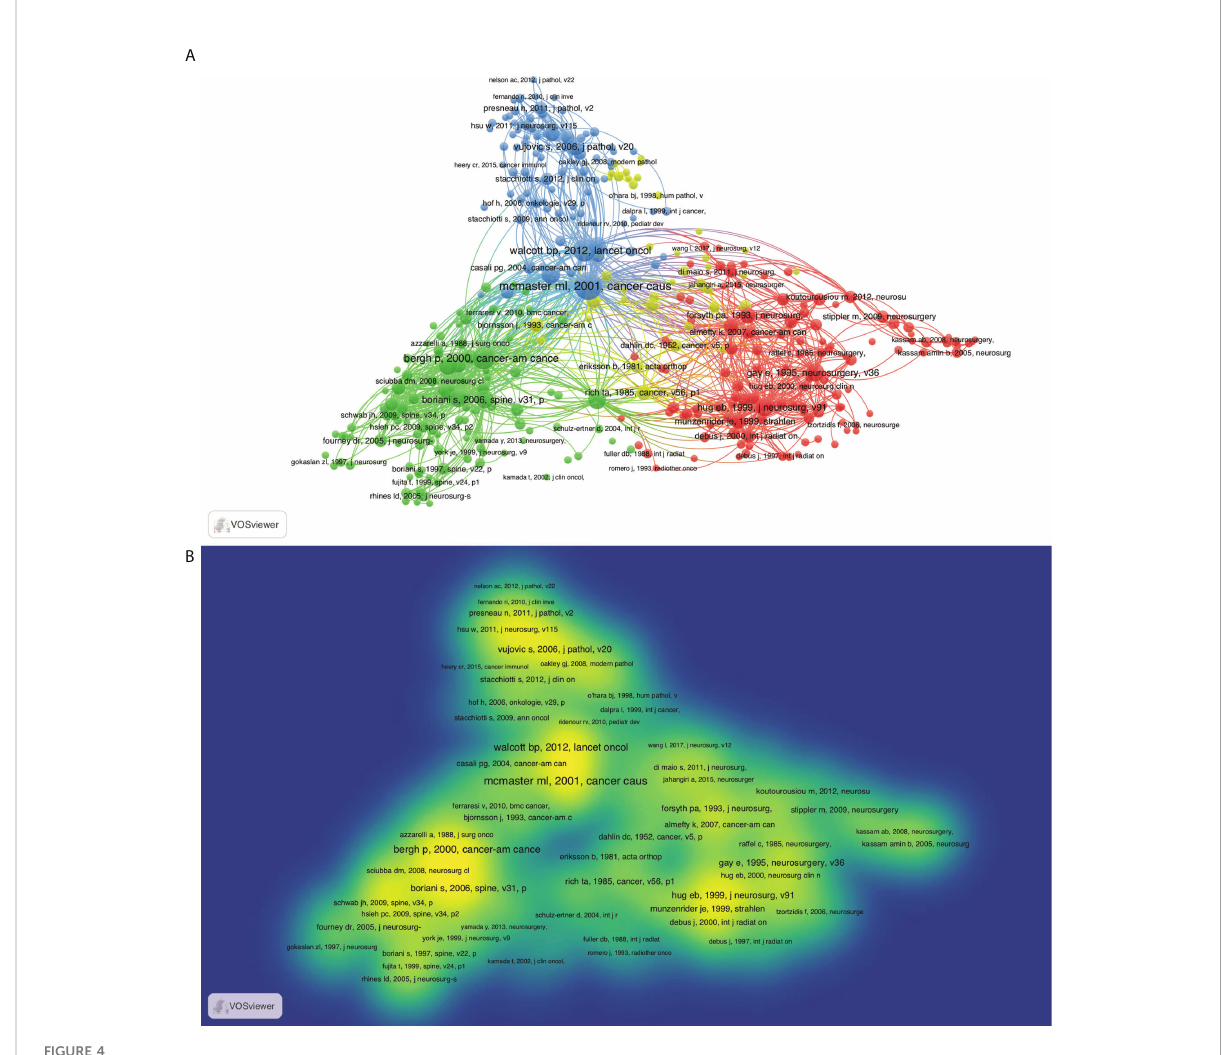
FIGURE 4 Co-citation map based on VOSviewer in chordoma fi eld. (A) Network visualization; (B) density